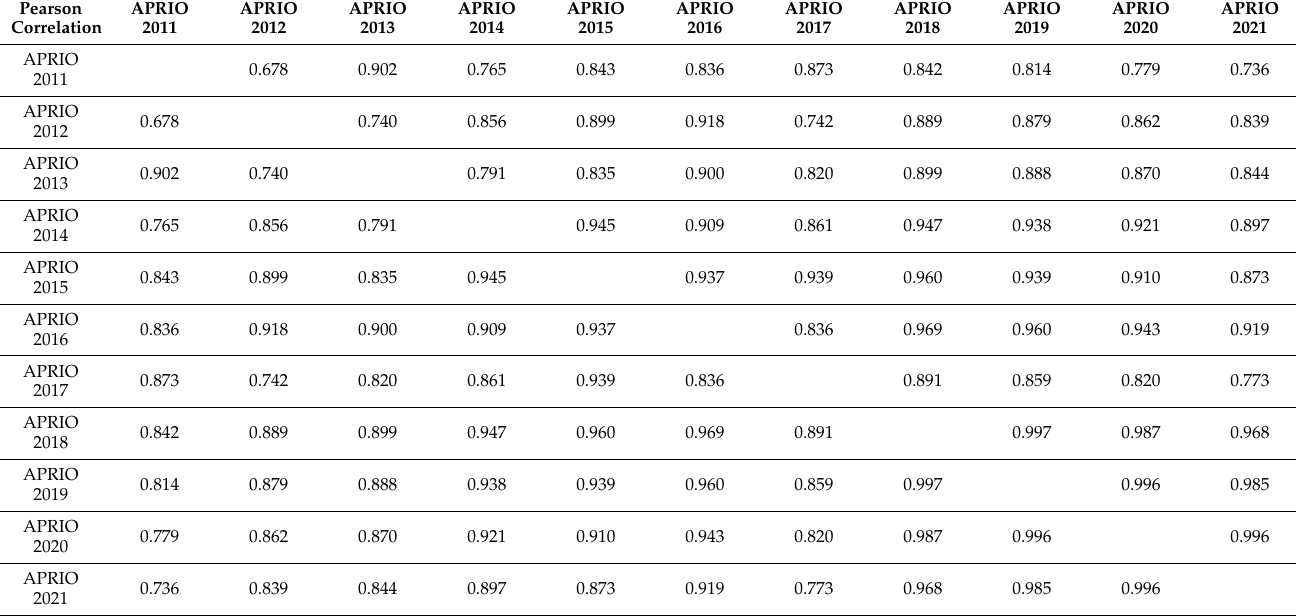
Table A3. Pearson correlation rates in dynamics for price indices of agricultural products indicator.